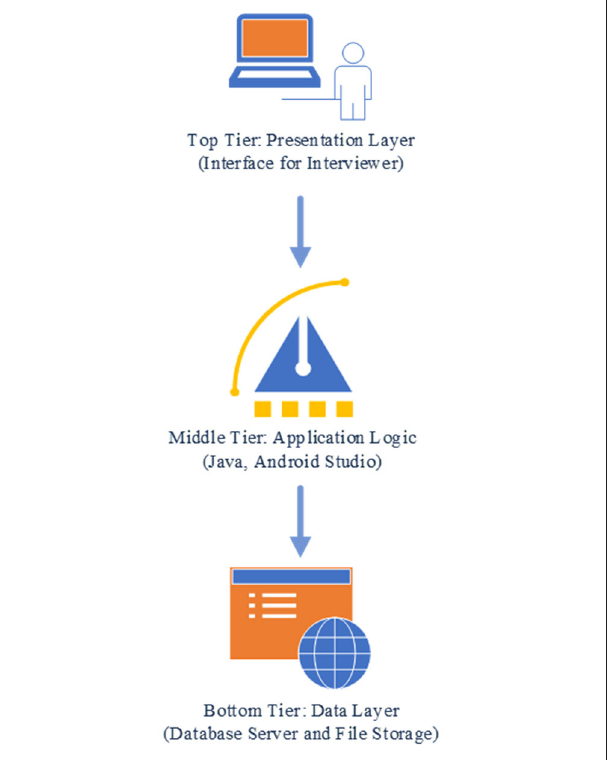
FIGURE 1 | Application